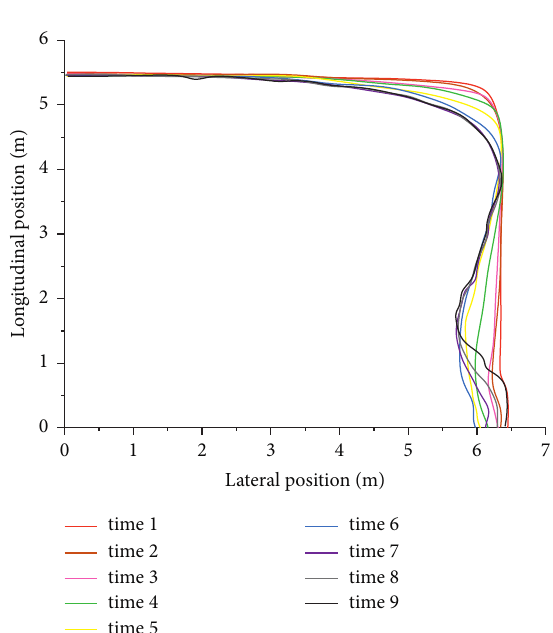
Figure 4: Summary diagram of the coal gangue boundary at 30 °